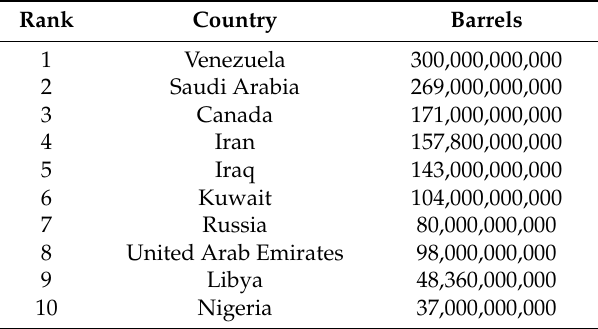
Table 1. Top ten countries with largest oil reserves